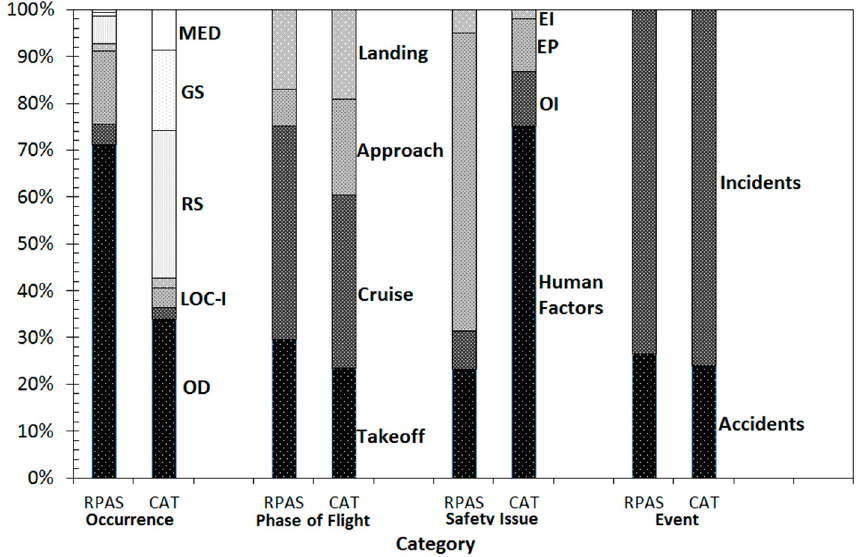
Figure 1. Distribution of accidents and incidents showing percentage proportion of subcategories vertically, for the categories (occurrence, phase of flight, safety issue, and event) horizontally, comparing Remotely Piloted Aircraft Systems (RPAS) with commercial air transportation (CAT) for each. Note, not all subcategory data labels are shown for occurrence type.